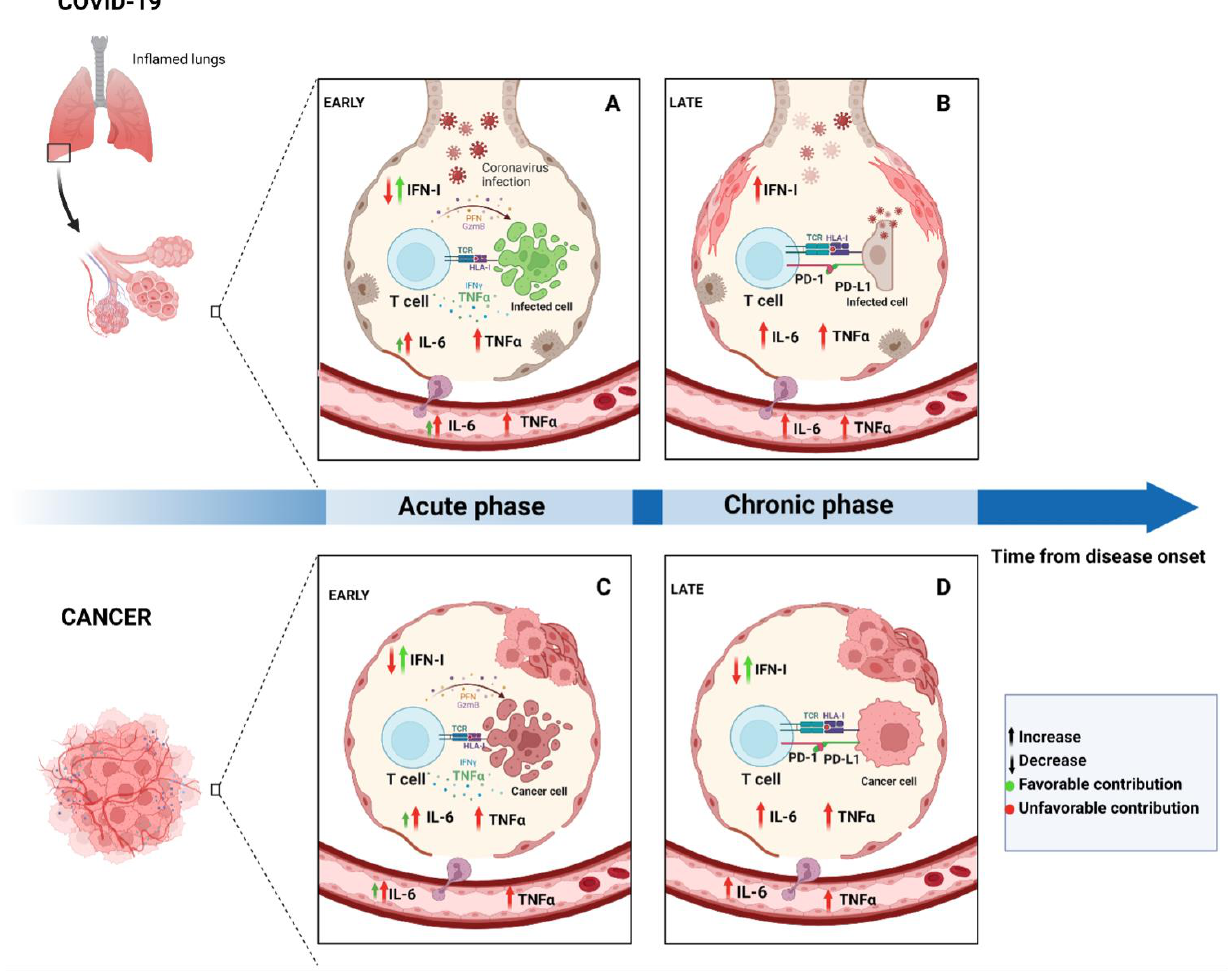
Figure 1. Time makes the difference. Schematic representation of the acute and chronic phases of inflammation in COVID-19 ( A , B ) and cancer ( C , D ), in the alveolar and tumoral microenvironments, respectively. Created with Biorender.com.